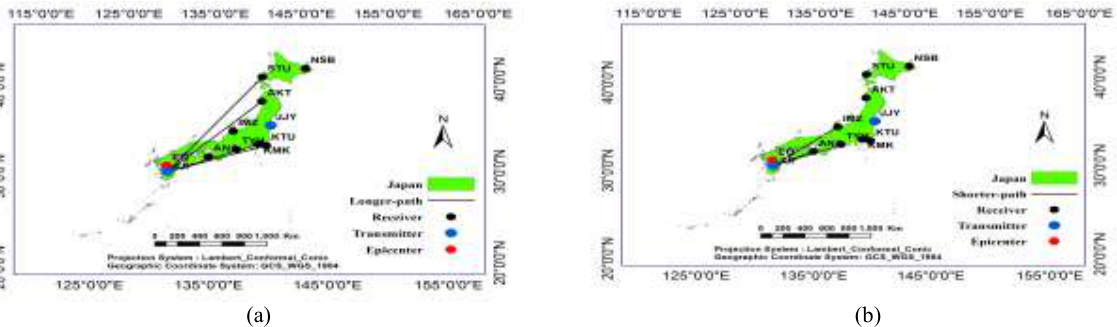
Figure 4(a) Longer-distance VLF/LF propagation paths (JJI-STU, JJI-AKT, JJI-KMK, JJI-KTU), (b) Shorter-distance VLF/LF propagation paths (JJI-ANA, JJI-IMZ, and JJI-TYH).